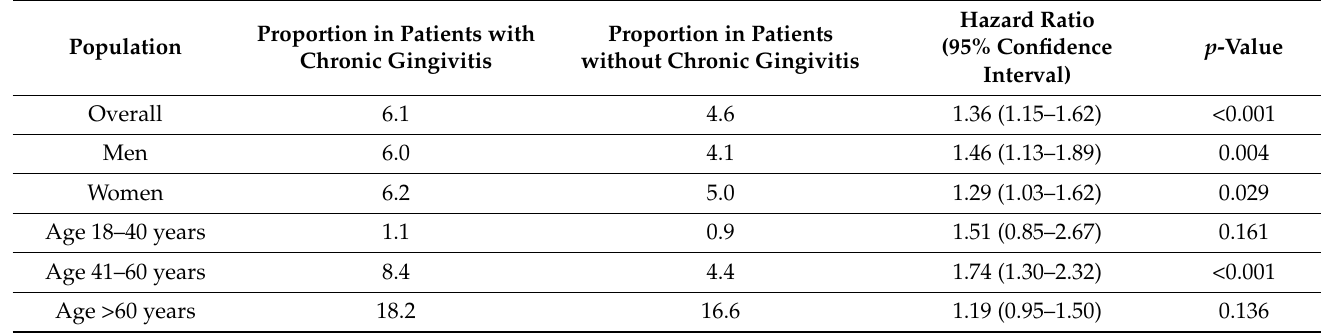
Table 2. Association between chronic gingivitis and the incidence of cancer in patients followed for up to 10 years in general practices in the United